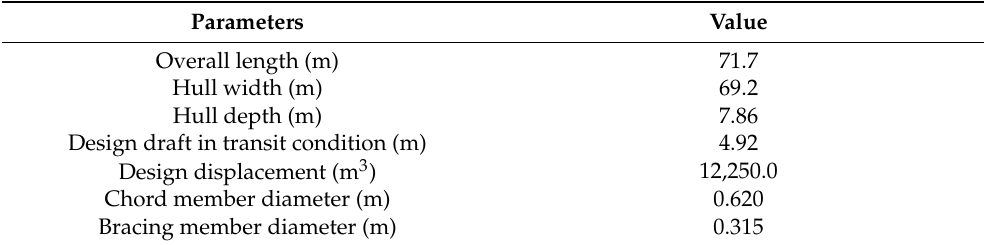
Table 1. Main particulars of the generic self-elevating unit.